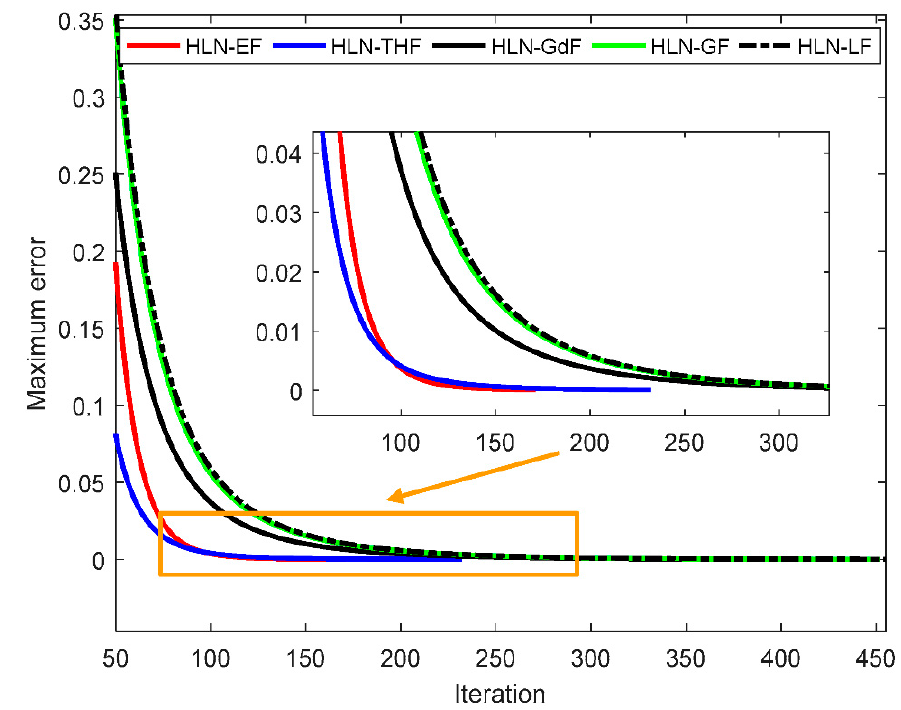
Figure 6. Maximum error vs. iteration for the first system with the second model of payment.